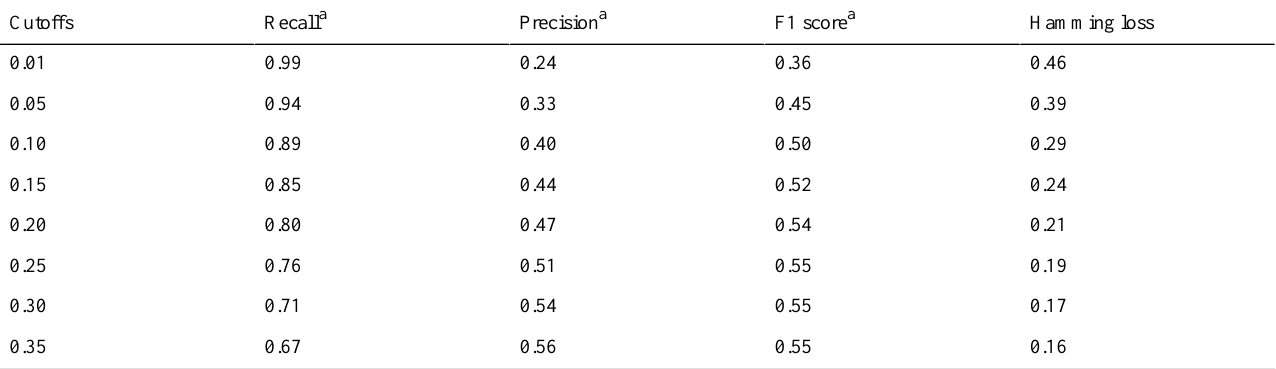
Table 2. Recall, precision, F1 score, and hamming loss of the model based on varying cutoffs for clinical laboratory test